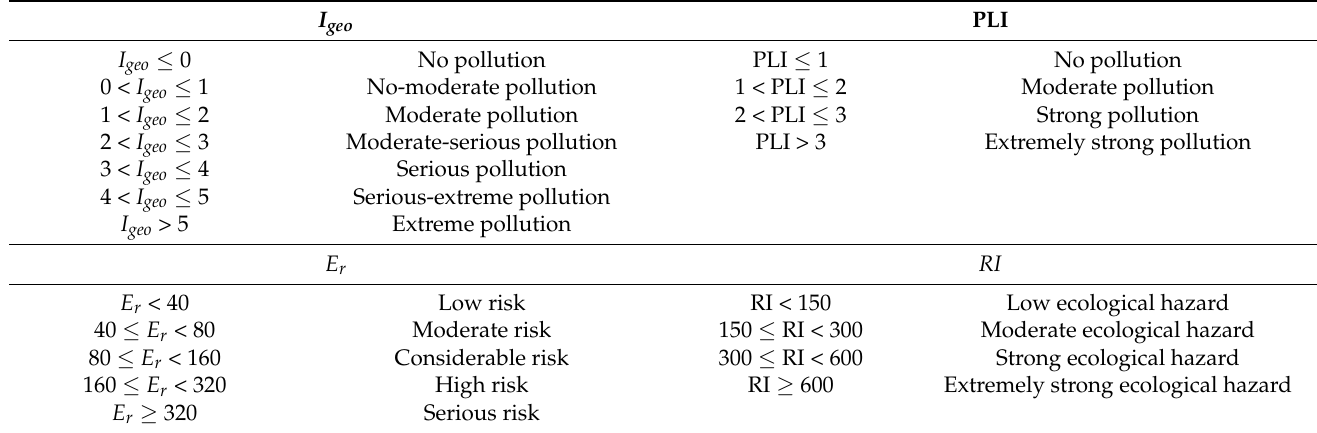
Table 1. Description of geo-accumulation ( I geo ), pollution load index (PLI), and potential ecological risk index ( E r